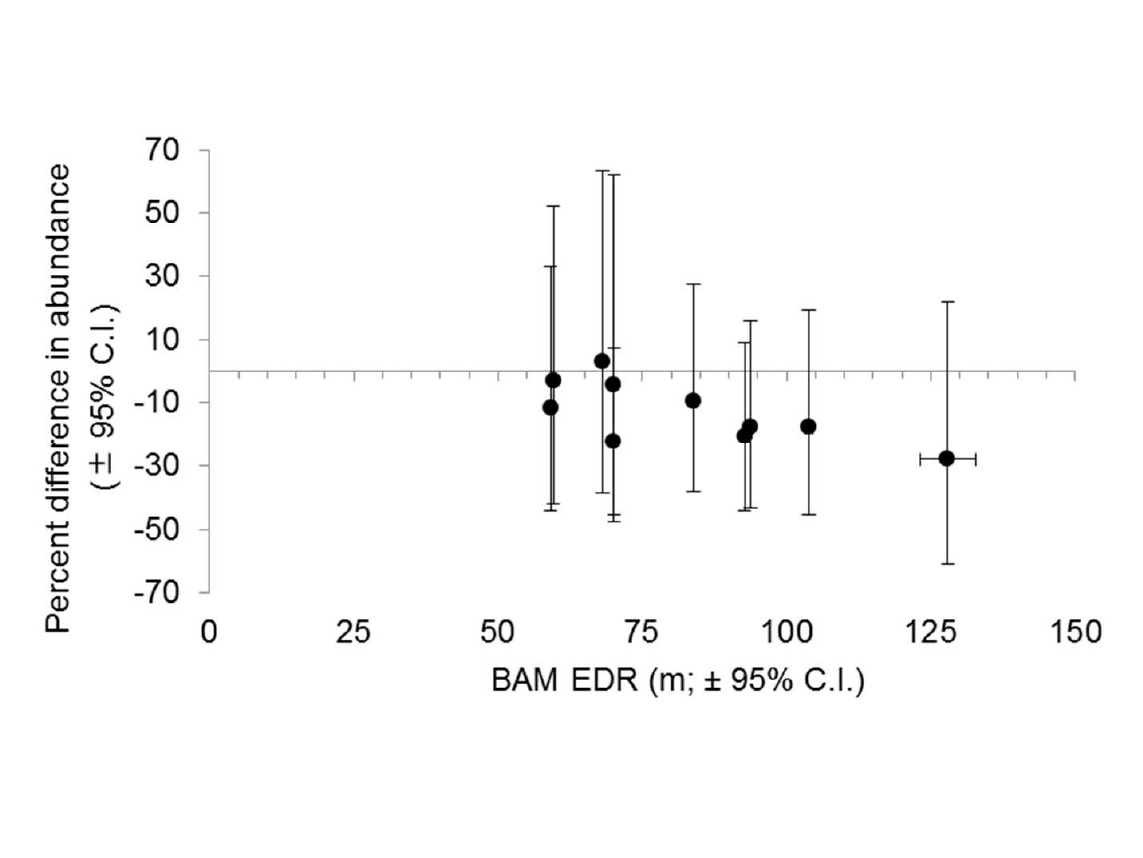
Figure A1.3. Relationship between BAM EDR (± 95% C.I.) and percent difference (± 95% C.I.) in relative abundance between on-road ARU BBS and forest-edge ARU BBS surveys (i.e. bias in detection). Each circle represents species-specific values. Bias values lower than 0 indicate higher counts for on-road ARU BBS surveys, while values higher than 0 indicate higher counts for forest-edge ARU BBS